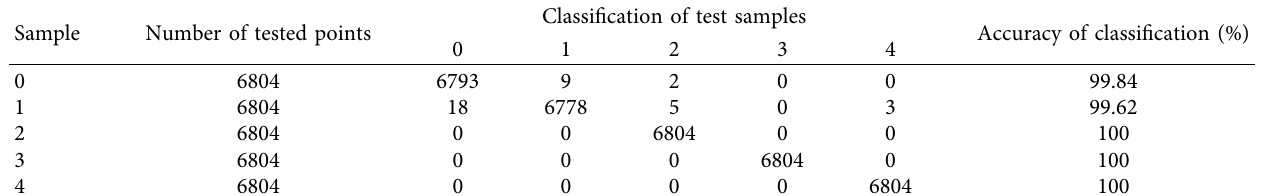
Table 4: Classification results of SVM model.